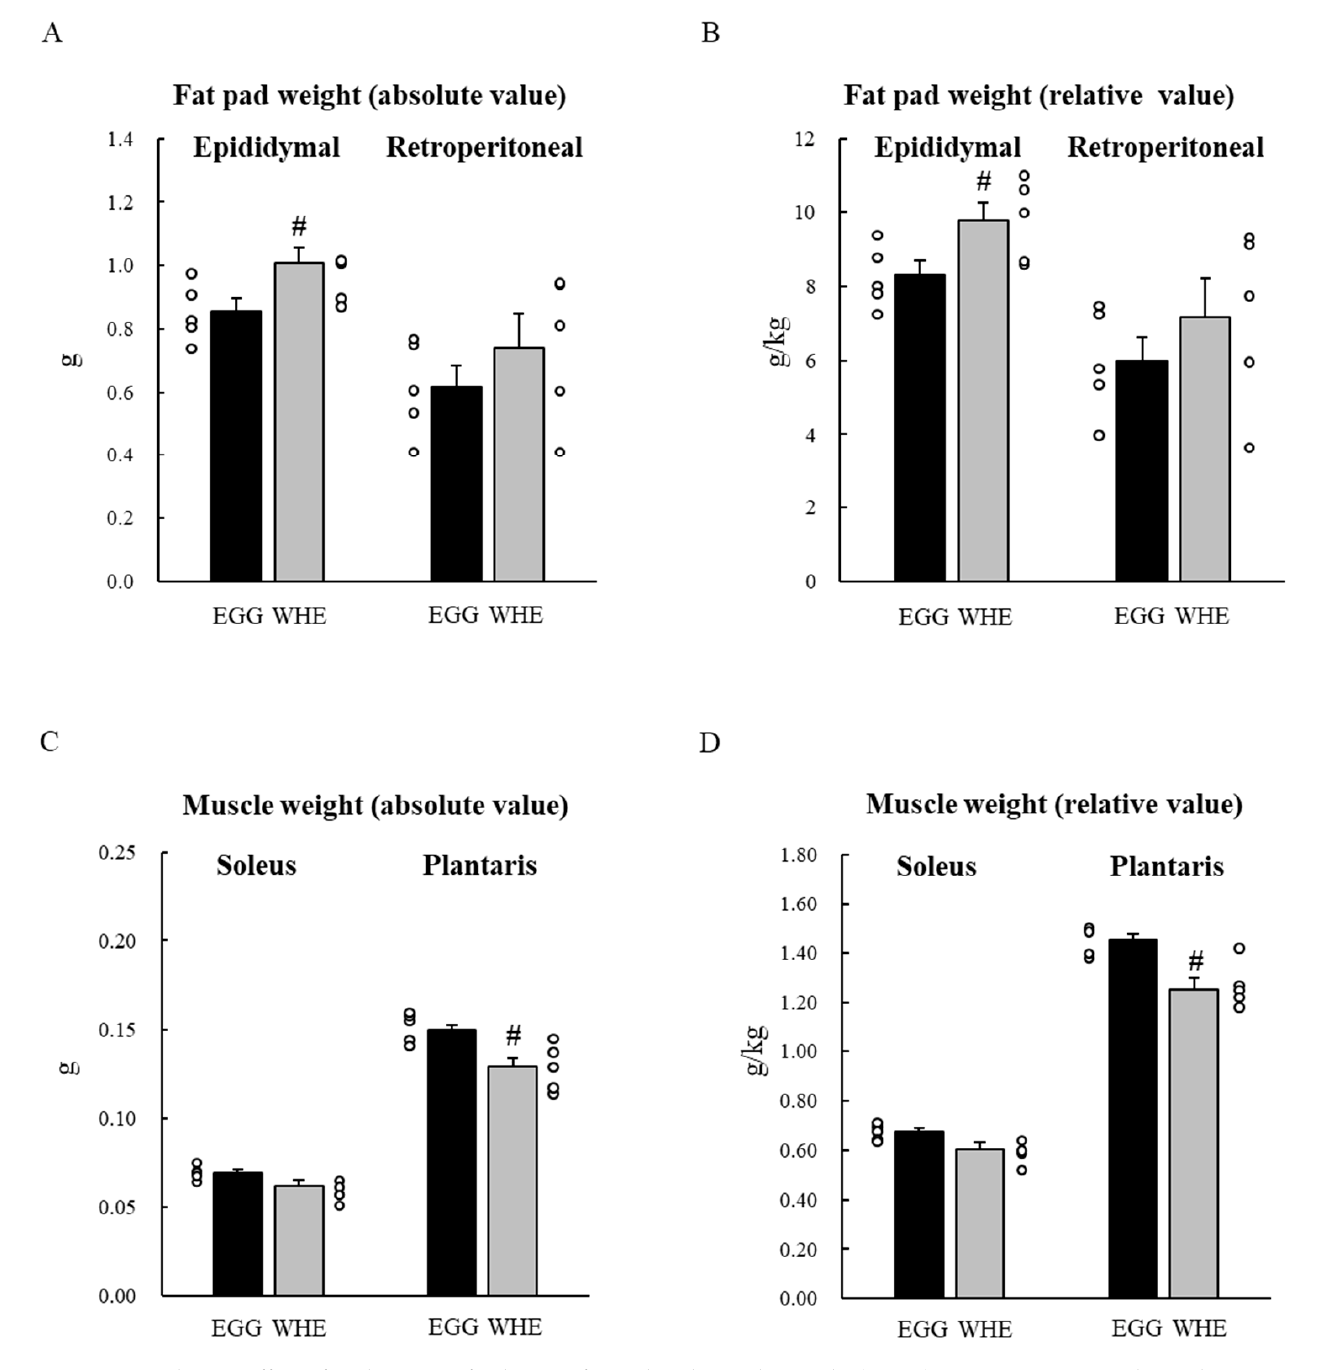
Figure 5. Chronic effect of each protein feeding on fat pad and muscle weight (Day 7). Rats were assigned to either an egg white, or whey protein diet group, and were maintained under ad libitum feeding for 7 days without clenbuterol administration. On day 7, rats were fasted for 6 h, and then fat pads ( A , B ) and muscles ( C , D ) were dissected out. An absolute value ( A , C ) and a relative value to body weight ( B , D ) were calculated. The dots beside bars indicate individual value. Values are means ± SE ( n = 7). CAS: casein protein, EGG: egg white protein, WHE: whey protein. #: p < 0.05 vs. EGG